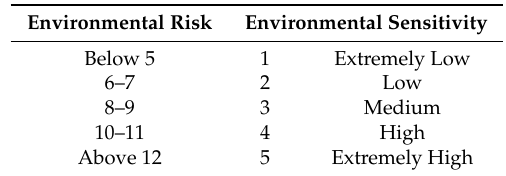
Table 5. Environmental sensitivity grading.